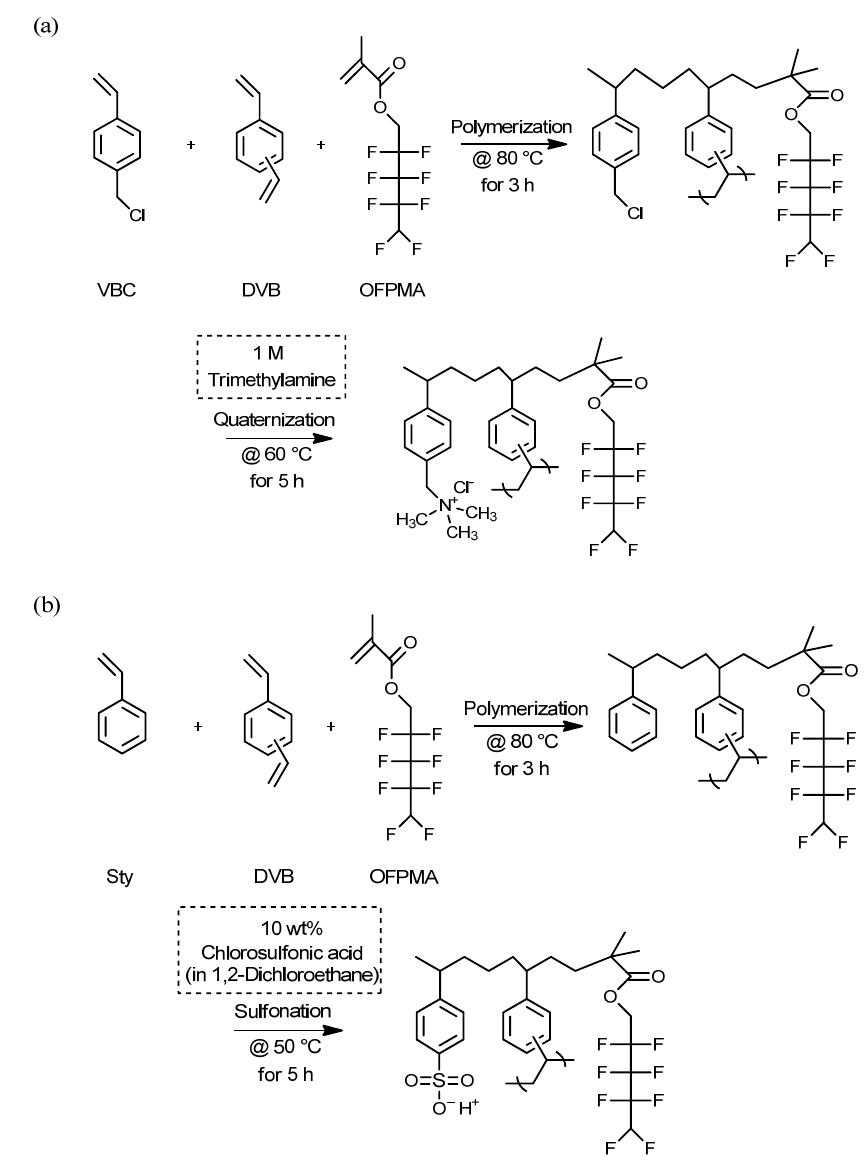
Figure 3. Reaction scheme of ( a ) quaternized anion-exchange polymer and ( b ) sulfonated cation- exchange polymer.